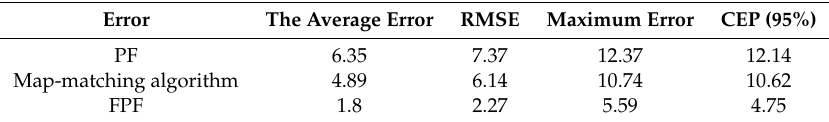
Table 2. Position errors for PF, the map-matching algorithm and FPF (m).